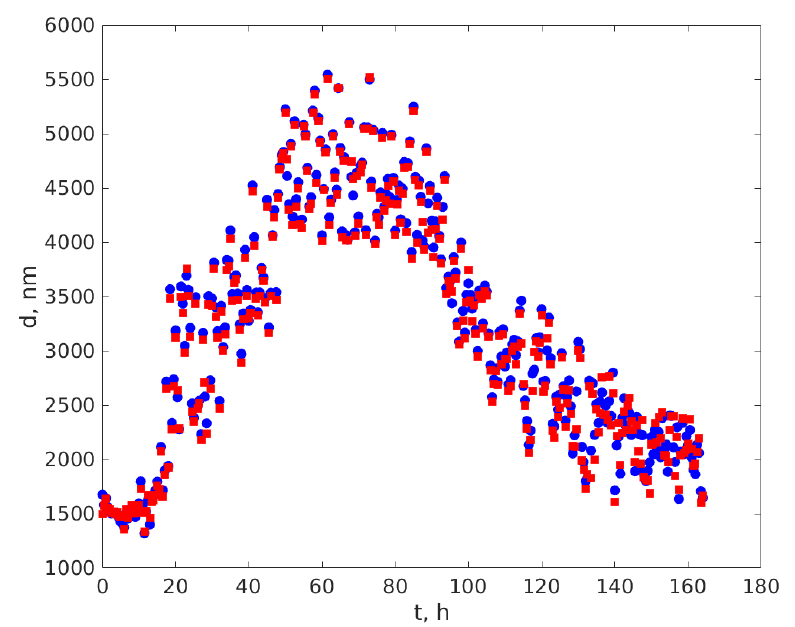
Figure 5. The average yeast cell diameters during fermentation. The circles depict diameters assessed using the reference procedure and the squares for the diameters assessed using the ANN assisted procedure.